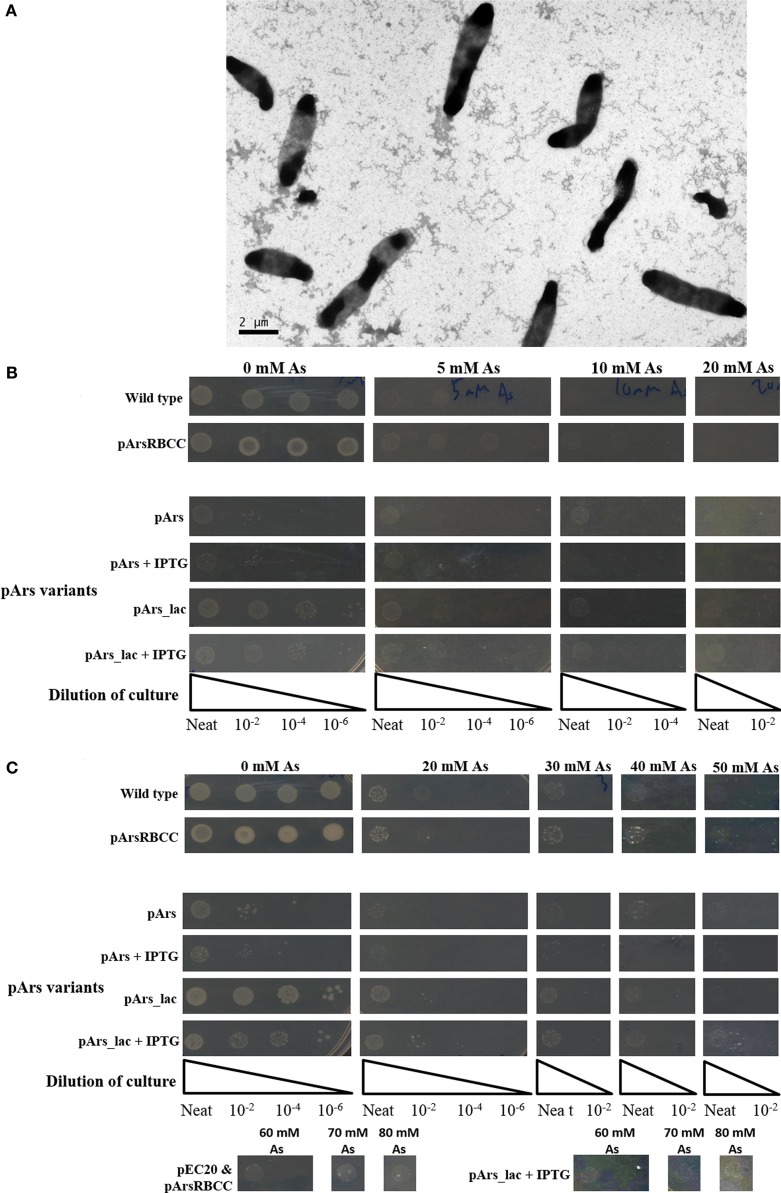
(A) Cells containing pArs after 16 h incubation at 37°C; (B) comparison of WT cells with pArs and pArs_lac cells, with and without IPTG induction, at various arsenic concentrations after 16 h incubation at 37°C and (C) after 3 days of incubation at 25°C.